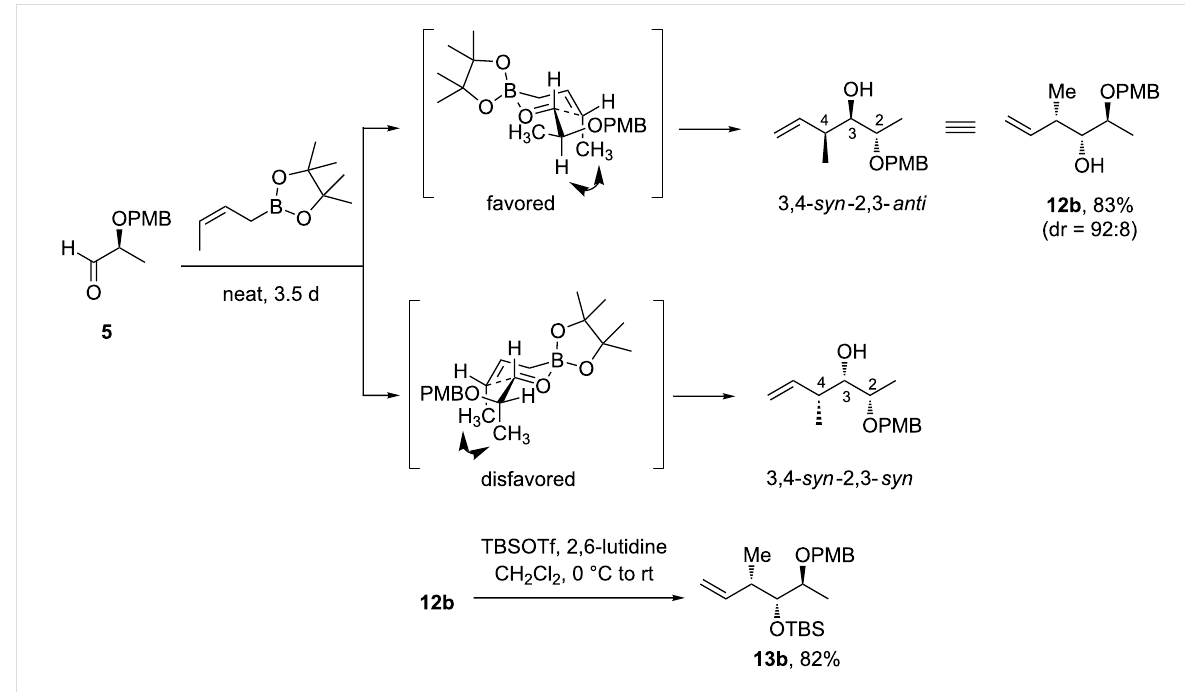
Scheme 2: Alternative preparation of 13b based on a diastereoselective